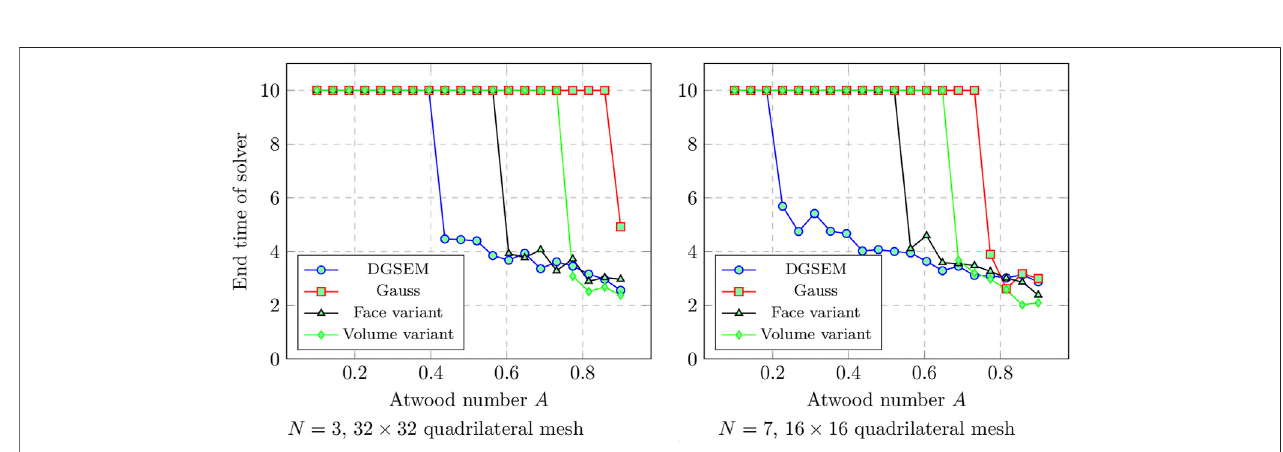
FIGURE 7 | Final times a solver an until as a function of Atwood number for the Kelvin-Helmholtz instability for DGSEM and different variants of entropy stable solvers based on the entropy projection. End times less than fi nal time T fi nal = 10 indicate a crash.